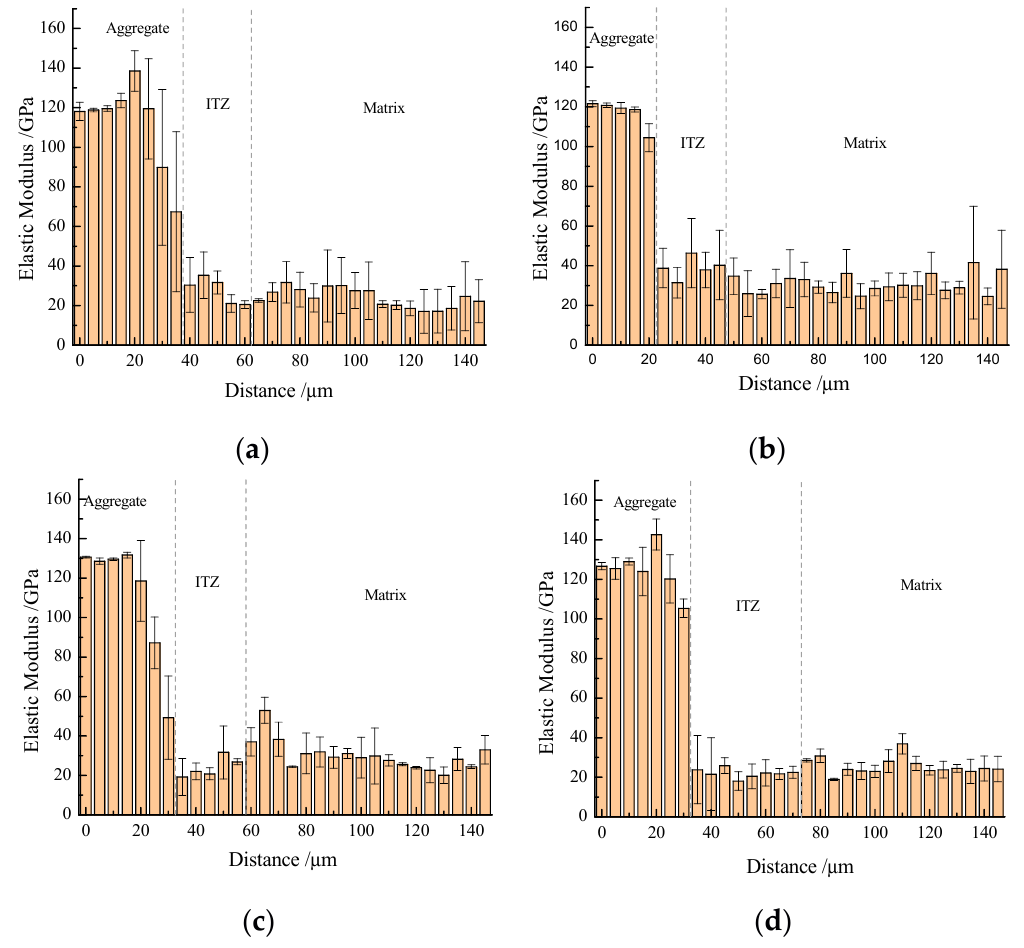
Figure 12. Nanoindentation modulus on ITZ of ( a ) C, ( b ) 80C + 20ZP, ( c ) 60C + 40ZP and ( d ) 40C + 60ZP.